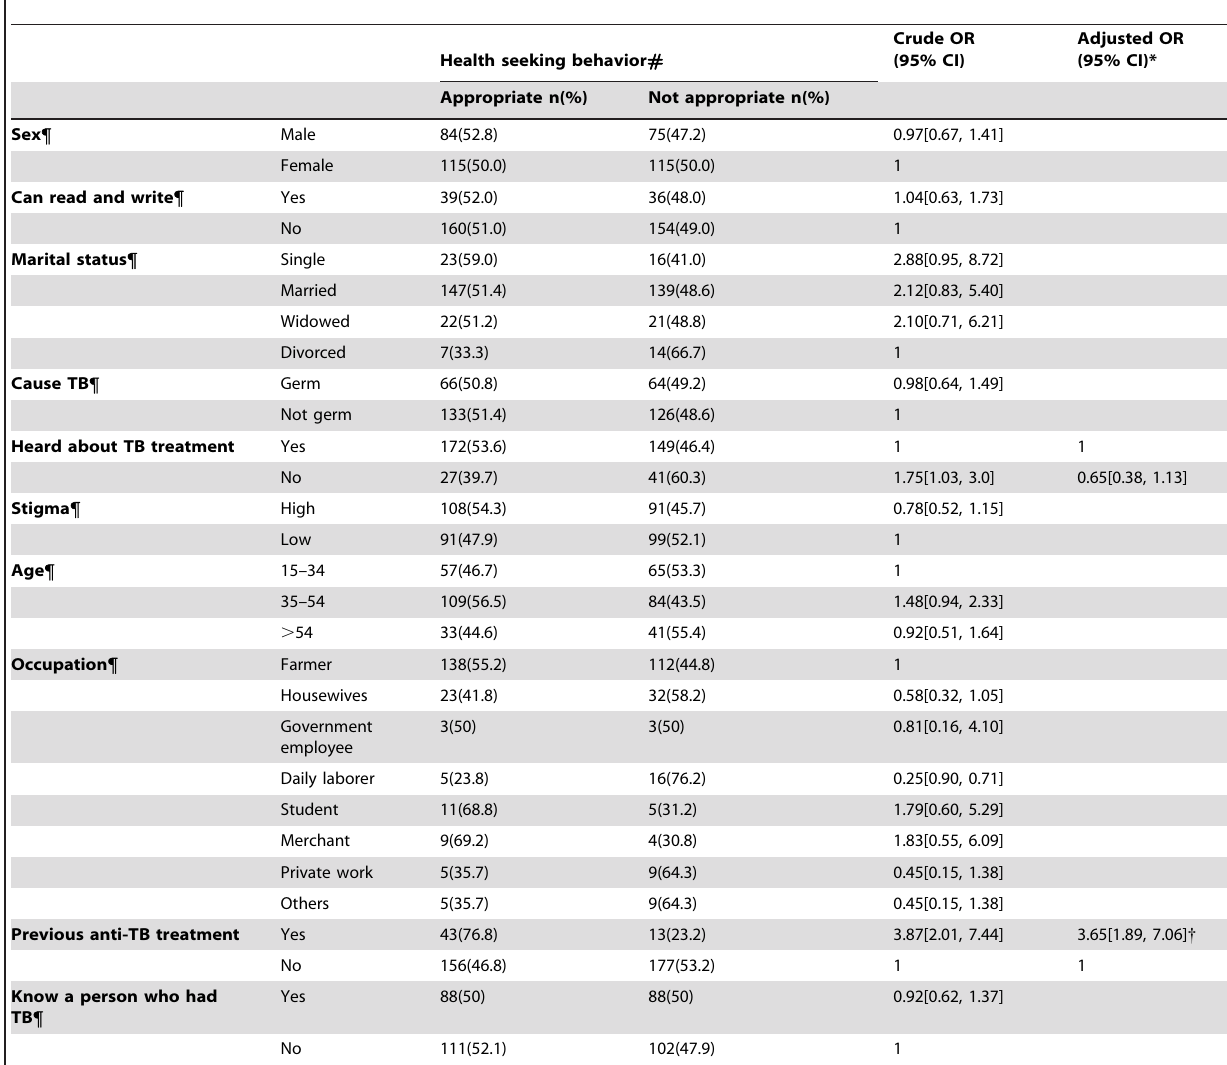
Table 6. Factors associated with health seeking behavior among TB suspects (n=389) in the Gilgel Gibe field research area, south west Ethiopia, March